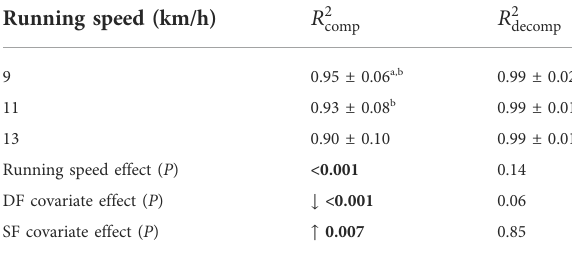
TABLE 4 Linearity of the force-length relationship during leg compression ( R 2 comp ) and decompression ( R 2 decomp ). Signi fi cant differences ( p ≤ 0.05) identi fi ed by linear mixed effects modeling are indicated in